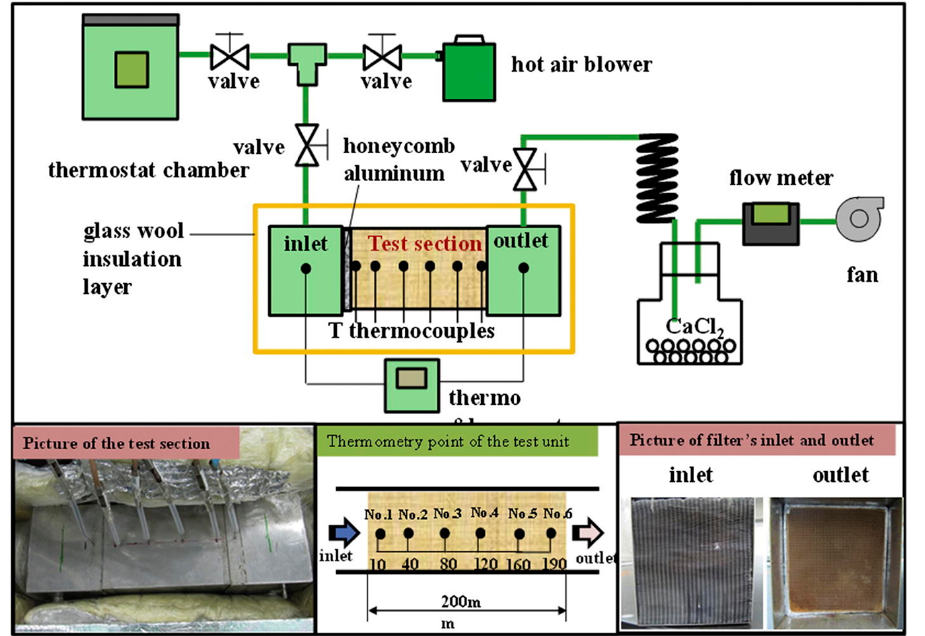
Figure 23. Schematic of the open adsorption TCES system [258]: Reprinted with permission from Ref. [258] Copyright © 2014 Elsevier Ltd. All rights reserved.